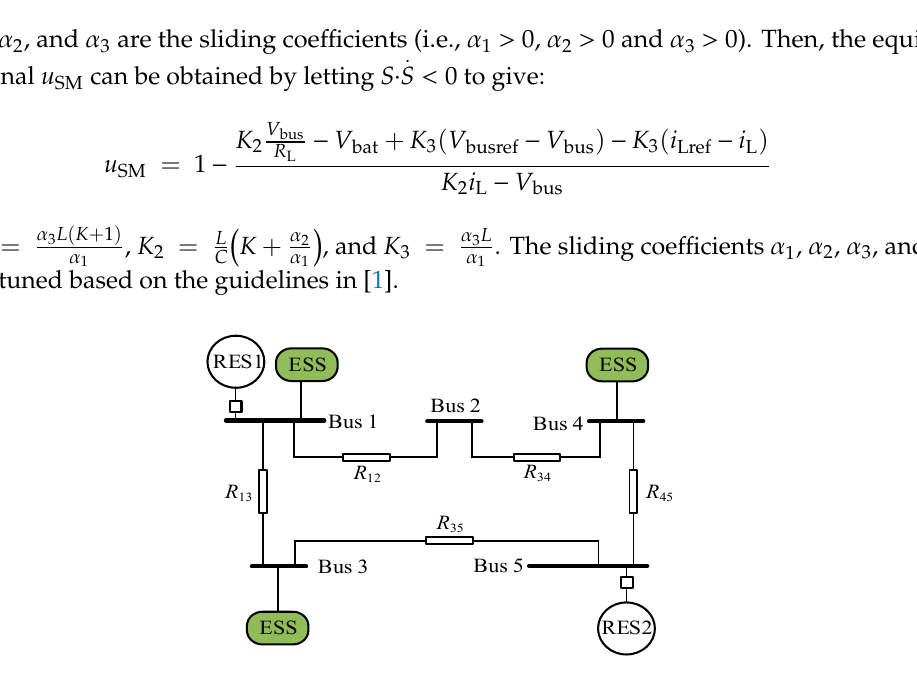
Figure 10. The structure of the investigated five-bus standalone DC microgrid.